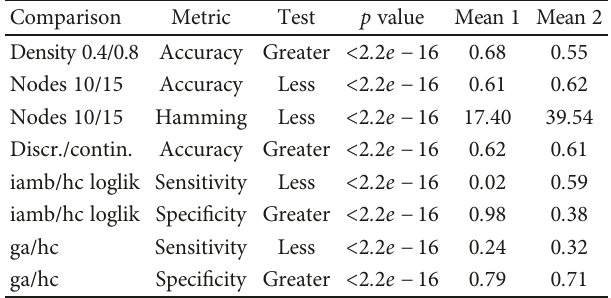
Table 1: Summary of the major fi ndings. The results of the Mann – Whitney U test [34] (one-tail test alternatives) in support of the results of our simulations are shown. The tests are performed on all the settings, with the comparisons as described in the fi rst column of the table. We also show the considered metric, the adopted alternative of the one-tail test, the obtained p value, and the mean of the two compared distributions of the